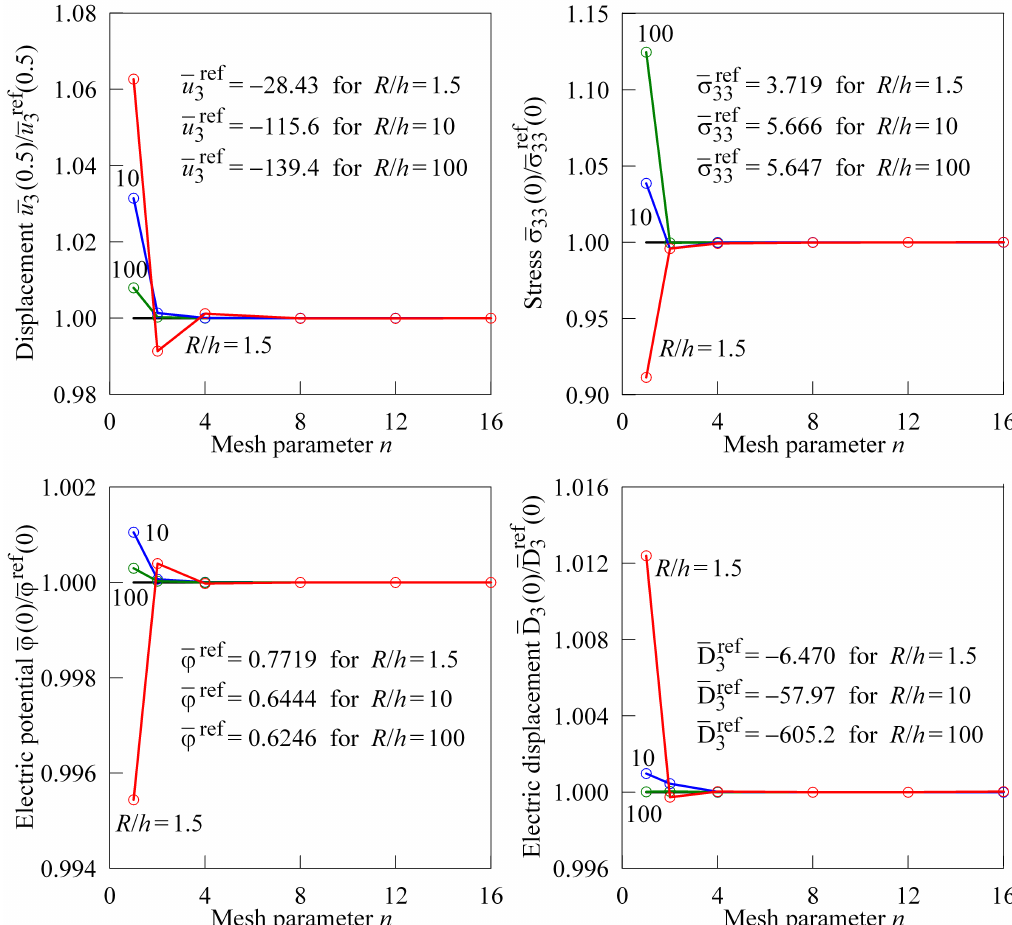
Figure 10: Convergence study due to mesh refinement for a FGM piezoceramic sphere with α = 1 and N = 9 using regular 4 n × 1 meshes with n = 1, 2, 4, 8, 12 and 16; reference solution is provided by using 128 × 1 mesh.